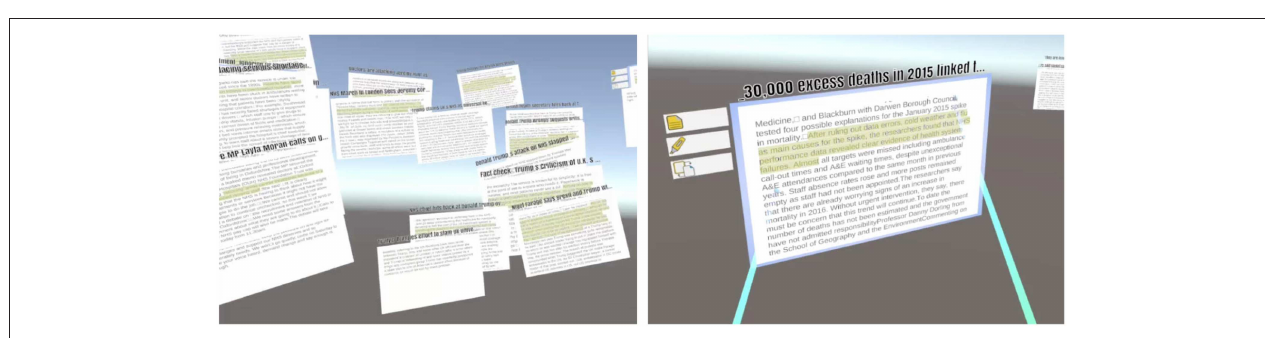
FIGURE 8 | Screenshots of a prototype IST application that allows users to organize and annotate documents and regions of space in immersive